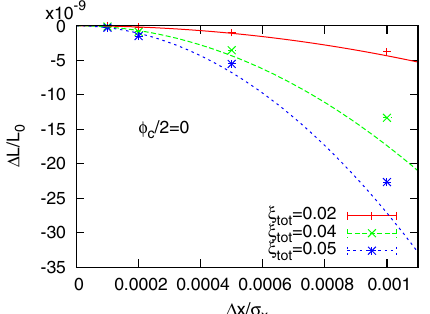
FIG. 19. Luminosity decrement as a function of the offset noise amplitude (for τ ¼ 1 ) in collisions without a crossing angle obtained from a weak-strong simulation (plotting symbols) compared with the predictions from Eq. (38) (the lines), for the working point ð ν x ; ν y Þ ¼ ð 0 . 31 ; 0 . 32 Þ